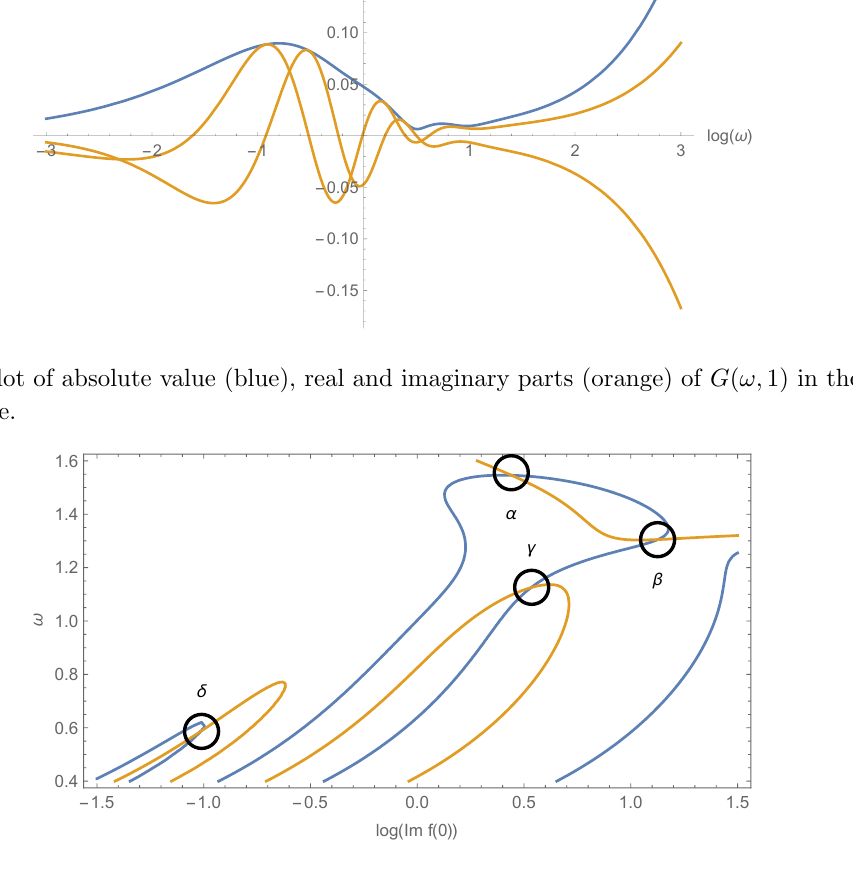
Figure 10 . Curves of vanishing real and imaginary parts of G ( !; Im f (0)) in the d = 5 hyperbolic case. We can identify four solutions (cid:11) , (cid:12) , (cid:13) , (cid:14) in order of decreasing !